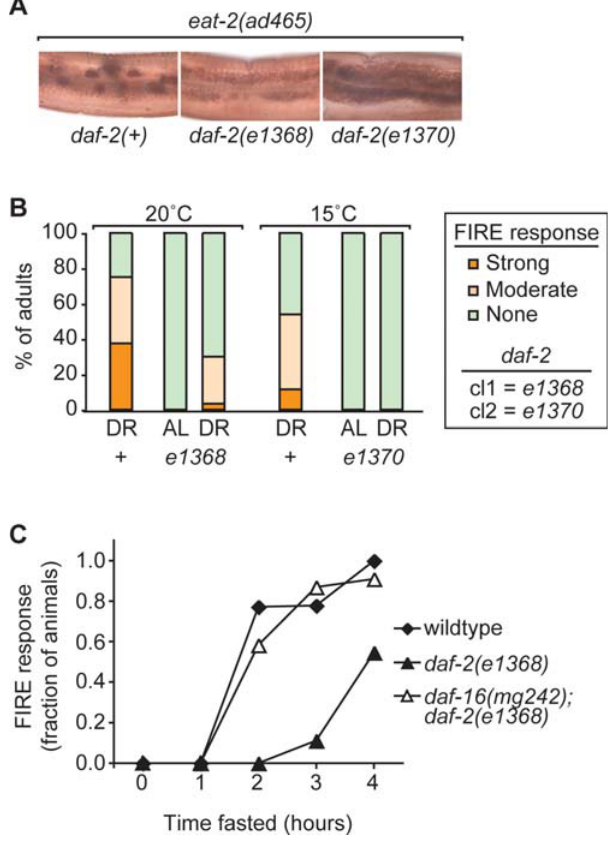
Figure 2. daf-2mutations suppressed DR-induced FIRE response. (A, B) Representative images showing FIRE response induction in eat- 2(ad465) animals and suppression in two different eat-2 ; daf-2 double mutants. (B) FIRE response suppression was stronger in daf-2(e1370) animals than in daf-2(e1368) animals. Quantification of the FIRE response in the same strains shown in (A); n=22–30 animals examined per strain, results are from one representative of three or more experiments. Assays were conducted at 20˚C for daf-2(e1368) and relevant controls or at 15˚C for daf-2(e1370) and controls. (C) daf-16 activity is required for resistance to FIRE-inducing conditions in daf-2 mutants but not wildtype animals. Graph shows the fraction of animals displaying a strong FIRE response during a time course of fasting; wildtype (diamonds), daf-16(mg242); daf-2(e1368) (open triangles) and daf-2(e1368) (filled triangles). Results are for one representative of 4 experiments; n=7–23 animals (average, 16 animals) examined per time point per strain; total number of animals examined per strain, wildtype (102 animals), daf-2(e1368) (65 animals), daf-16(mg242); daf-2(e1368) (72 animals). Consistent results were also observed after let-363 /TOR